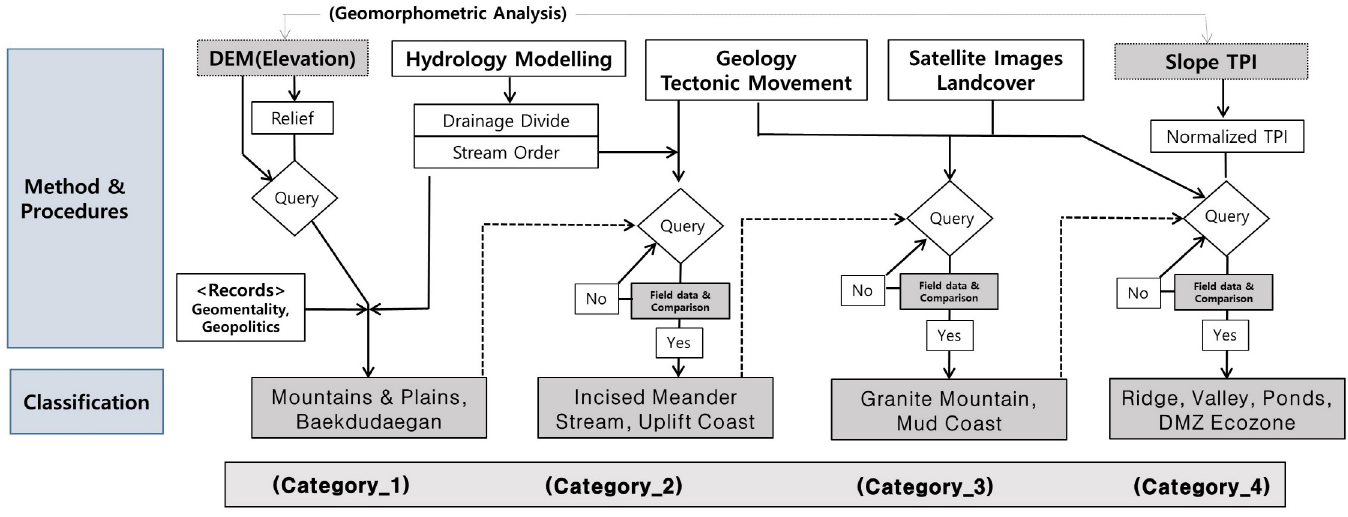
Fig 2. Flowchart showing the overall process of landform